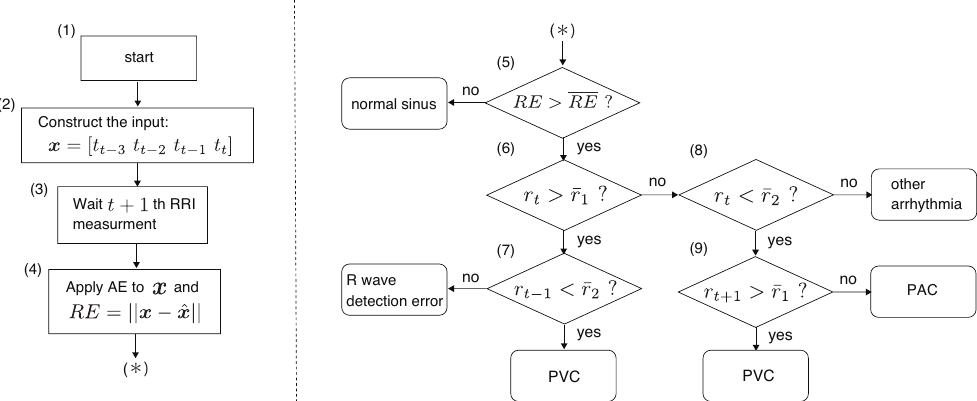
Figure 5. Flowchart of AED. This procedure can classify the RRI data into normal sinus, PVC, PAC, R wave detection error, or another type of